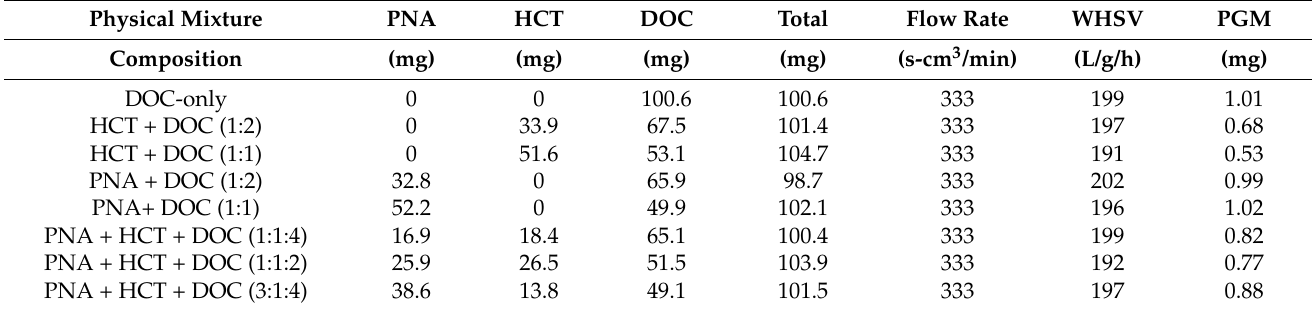
Table 2. Physical mixture experimental matrix with varying PNA, HCT, and DOC ratios.